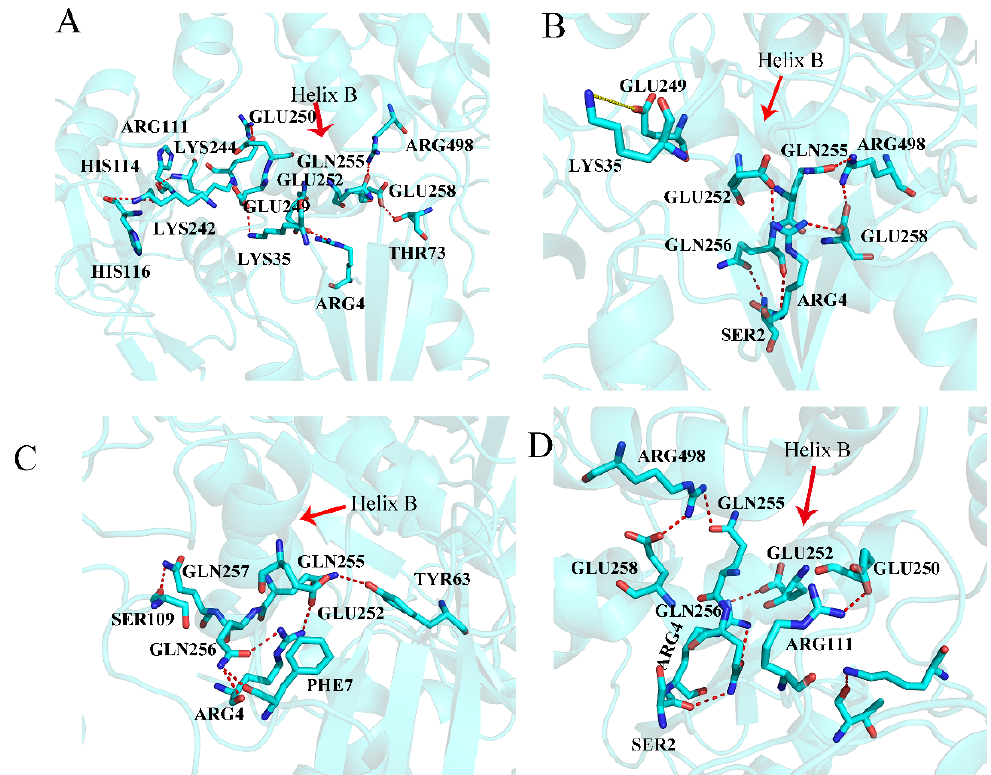
Figure 6. The hydrogen bonds of key helix B in system SHP2 ( A ), system EPIYA-D-N ( B ), system EPIYA-C-N ( C ), and system EPIYA-C-DUAL ( D ). The red dotted line means there is a hydrogen bond between the two residues, and the yellow dotted line means that the distance is too great to form a hydrogen bond (more than 3.5Å).